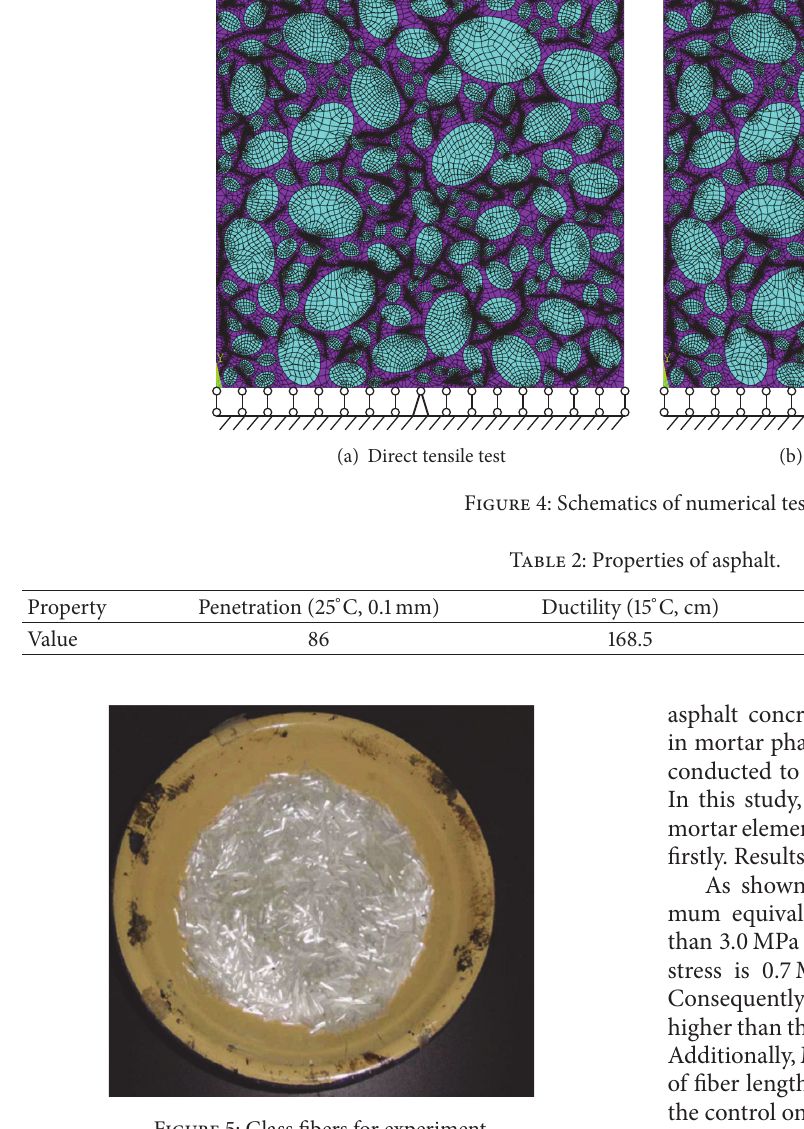
Figure 5: Glass fibers for